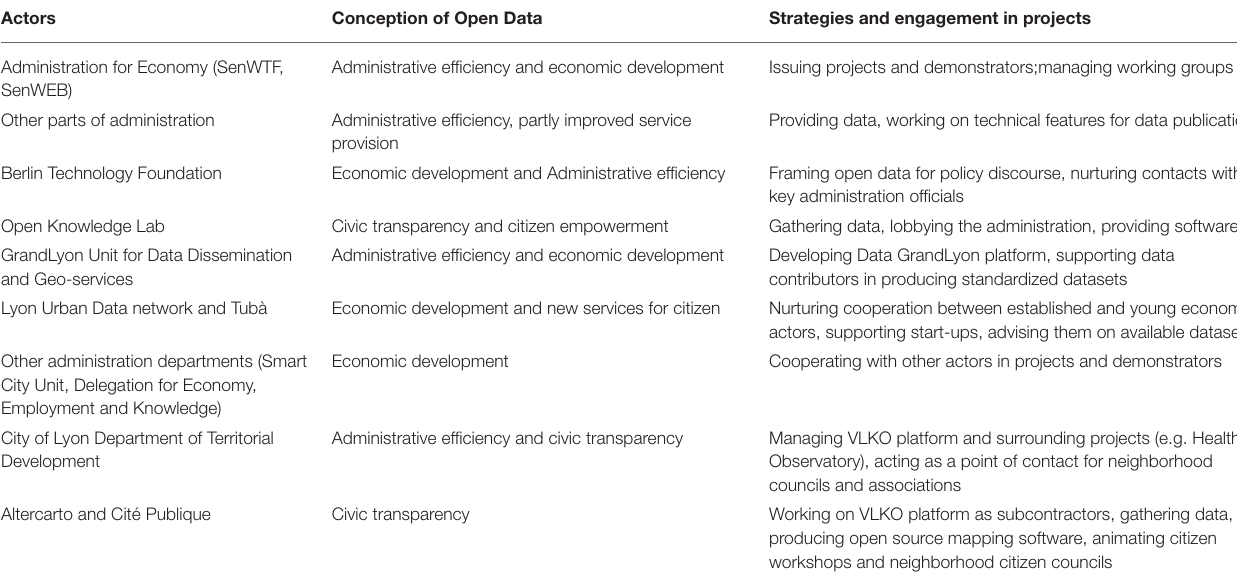
TABLE 5 | Main actors, their strategies and conception of open data in Berlin and Lyon.